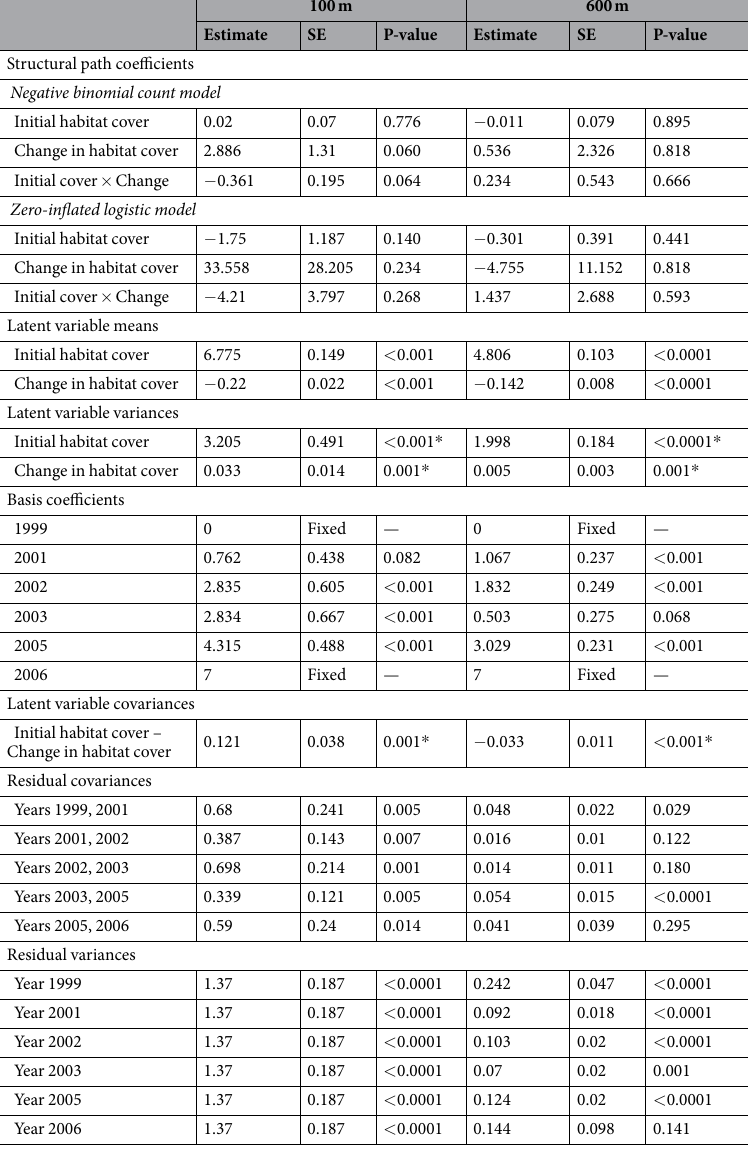
Table 1. Results of two separate latent growth curve models examining how change in habitat cover, initial level of habitat cover and their interaction at the territory core (100 m) and the landscape (600 m) scales were associated with the total number of fledged offspring produced during the study period. Note that regression coefficients on negative binomial and zero-inflated logistic models are on log and logit scales, respectively, and that the p-values of factor variances are halved because, by definition, these cannot be negative (Hox 2010). * Statistical significance determined with likelihood ratio